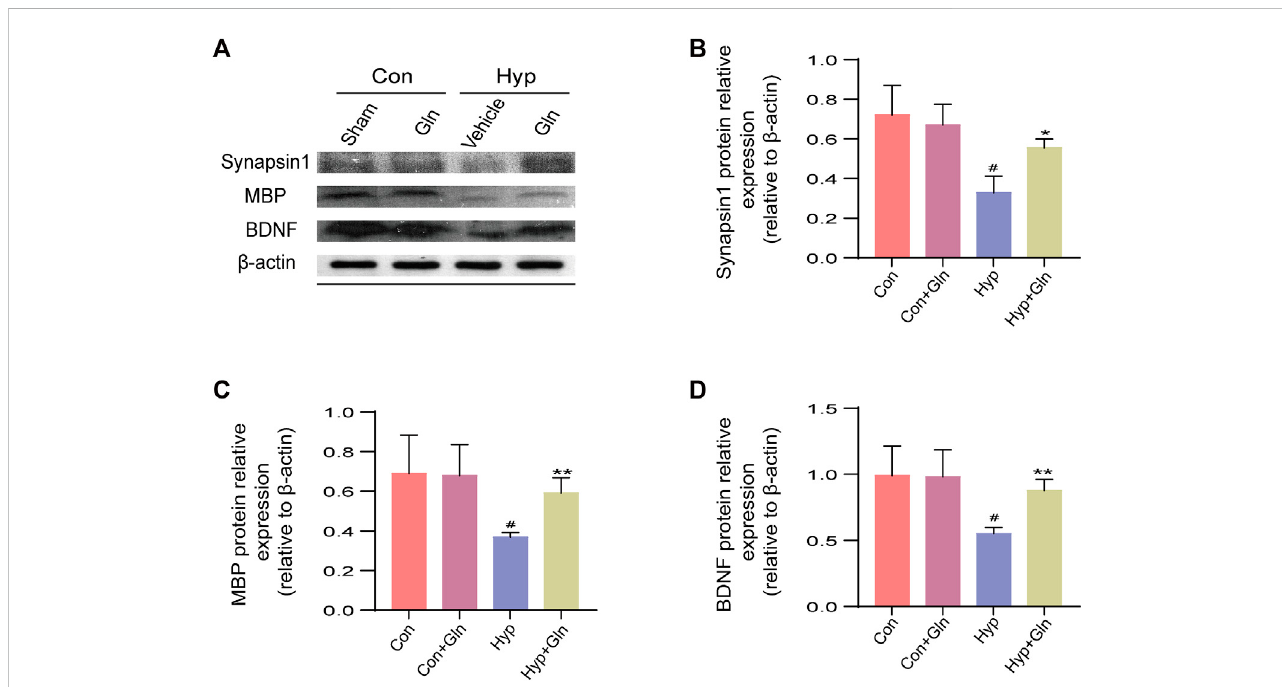
FIGURE 7 Gln increases BDNF, synapsin-1 and MBP expression in hippocampal tissue of rats with hyperoxia-induced brain injury. (A) Representative images of Western blotting analysis of synapsin-1, MBP and BDNF of each group. (B) Synapsin-1 content in hippocampus. Con (0.72 ± 0.09), Con + Gln (0.67 ± 0.06), Hyp (0.33 ± 0.05), Hyp + Gln (0.55 ± 0.03). (C) MBP content in hippocampus. Con (0.69 ± 0.11), Con + Gln (0.68 ± 0.09), Hyp (0.37 ± 0.01), Hyp + Gln (0.59 ± 0.04). (D) BDNF content in hippocampus. Con (0.99 ± 0.13), Con + Gln (0.98 ± 0.12), Hyp (00.55 ± 0.03), Hyp + Gln (0.88 ± 0.05). ( n = 3). # p < 0.05 vs. the Con, * p < 0.05, ** p < 0.01 vs. the Hyp. p < 0.05 was considered statistically signi fi